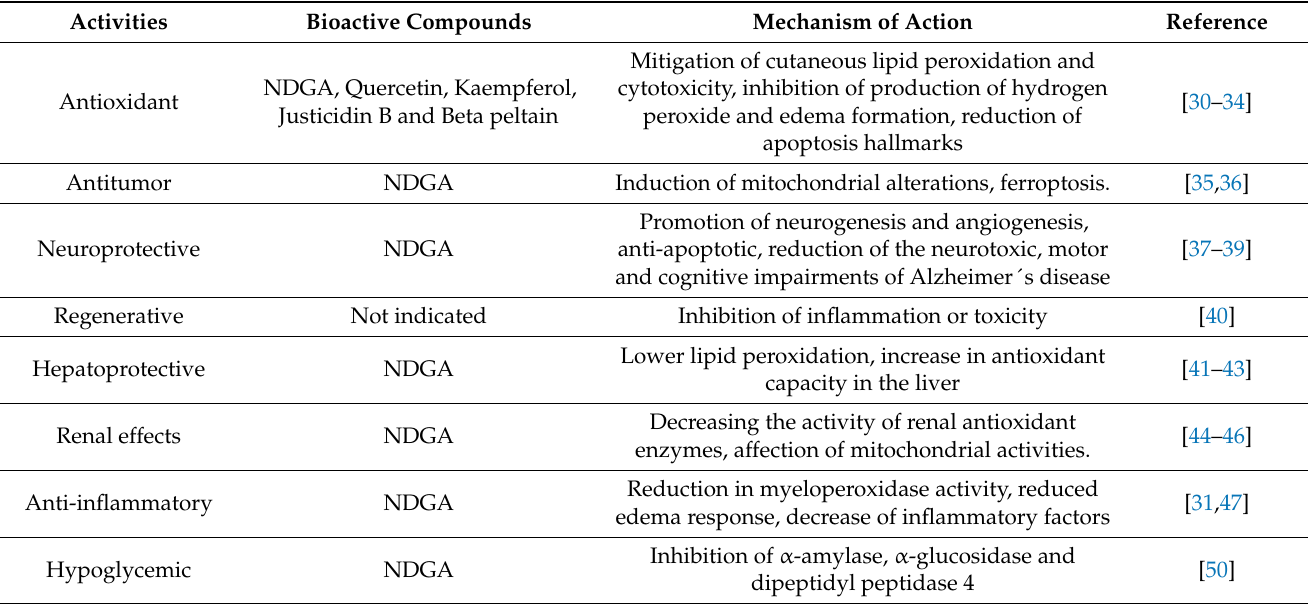
Table 4. Pharmacological activities of L. tridentata its related compounds and mechanism of